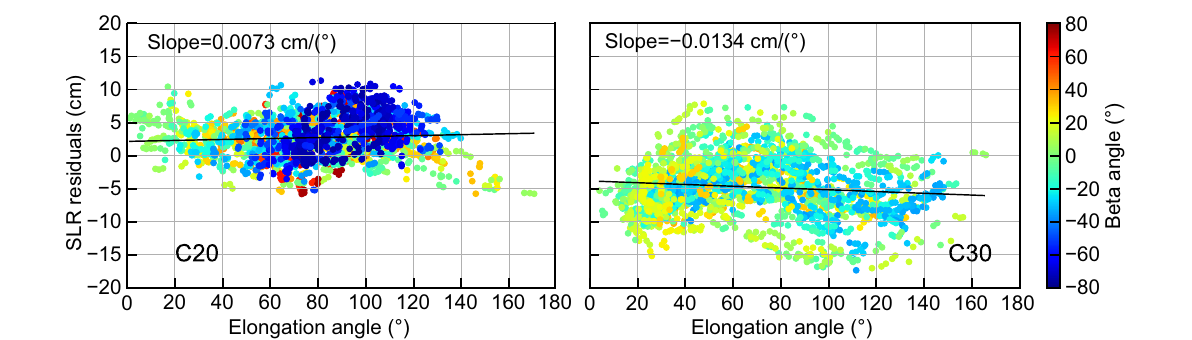
Fig. 12 SLR residuals of C20 (left) and C30 (right) orbits determined with L-band (left) only and ISL-only (right) observables with respect to the Sun elongation